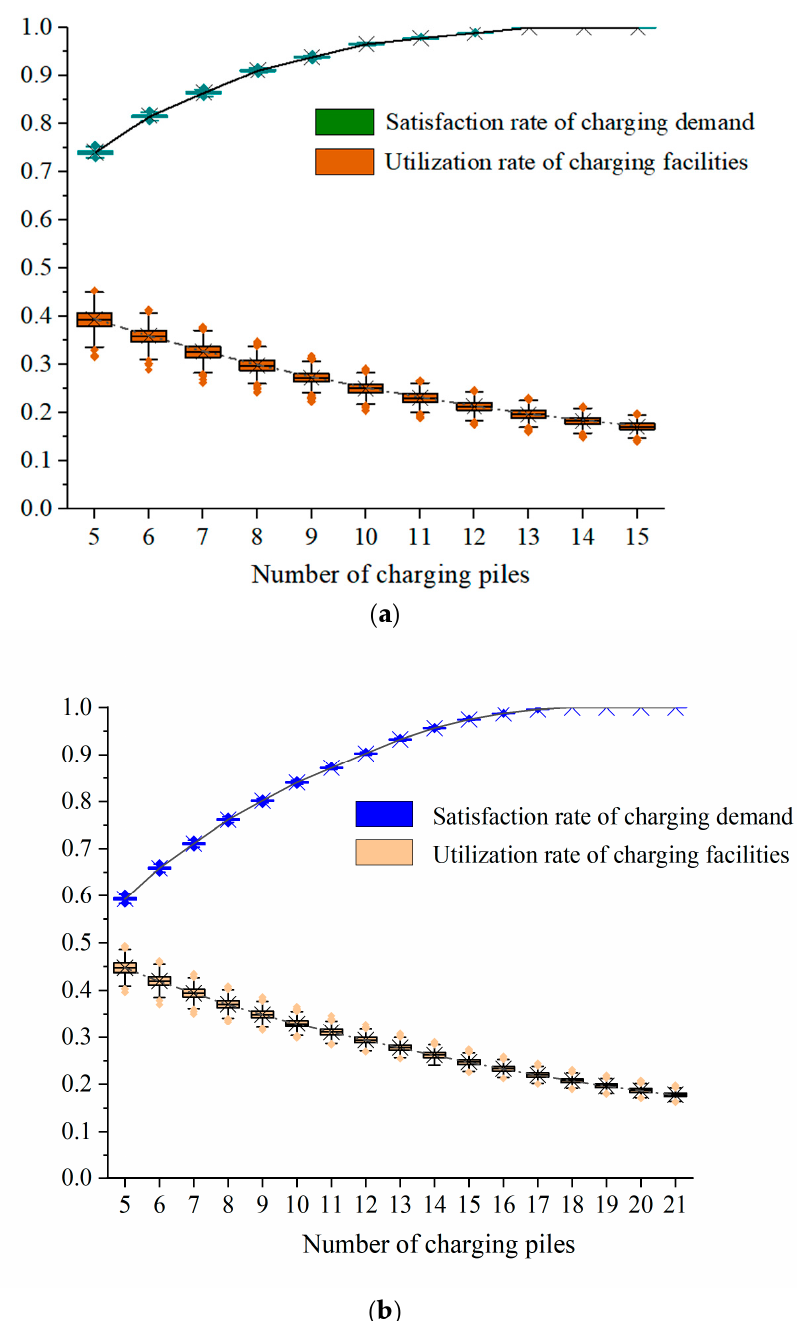
Figure 5. Indicator comparison of configuration scheme: ( a ) Design period (Y = 5); ( b ) Design period (Y = 10).